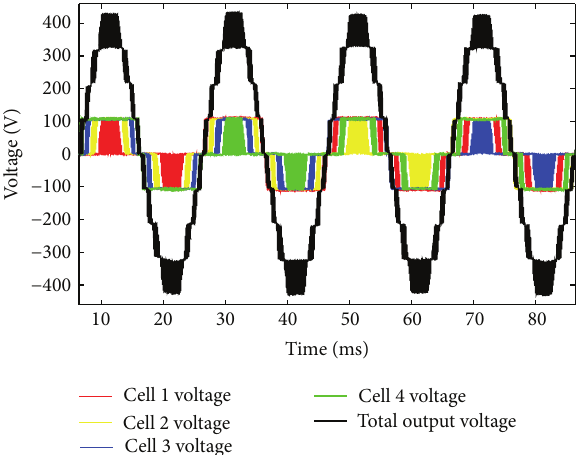
Figure 15: Rotating the cell order to vary the power output from each cell. The average power for four cycles is evenly distributed among the